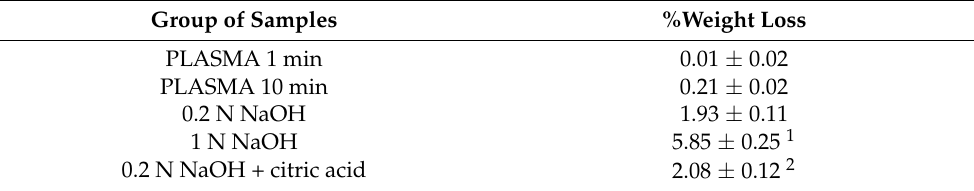
Table 1. Weight loss (%) due to the application of the different surface treatments evaluated. Group of